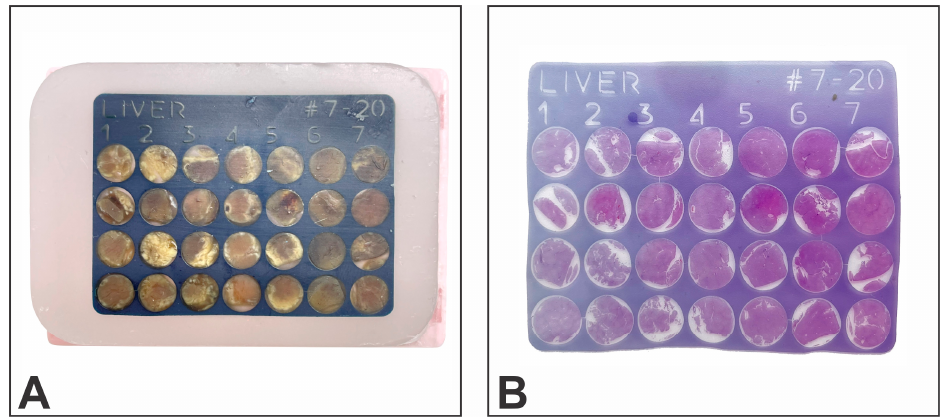
Figure 3. Liver tissue microarray: ( A ) sectionable matrix “receptor” block loaded with tissue cores, ( B ) hematoxylin-eosin stain.